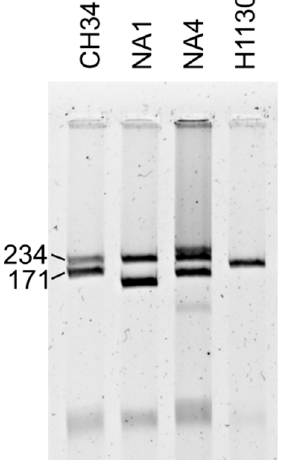
Figure 1. Agarose gel electrophoresis of Cupriavidus metallidurans CH34, NA1, NA4 and H1130 (mega)plasmid DNA. The characterized CH34 megaplasmids pMOL30 (234 kb) and pMOL28 (171 kb) serve as reference.